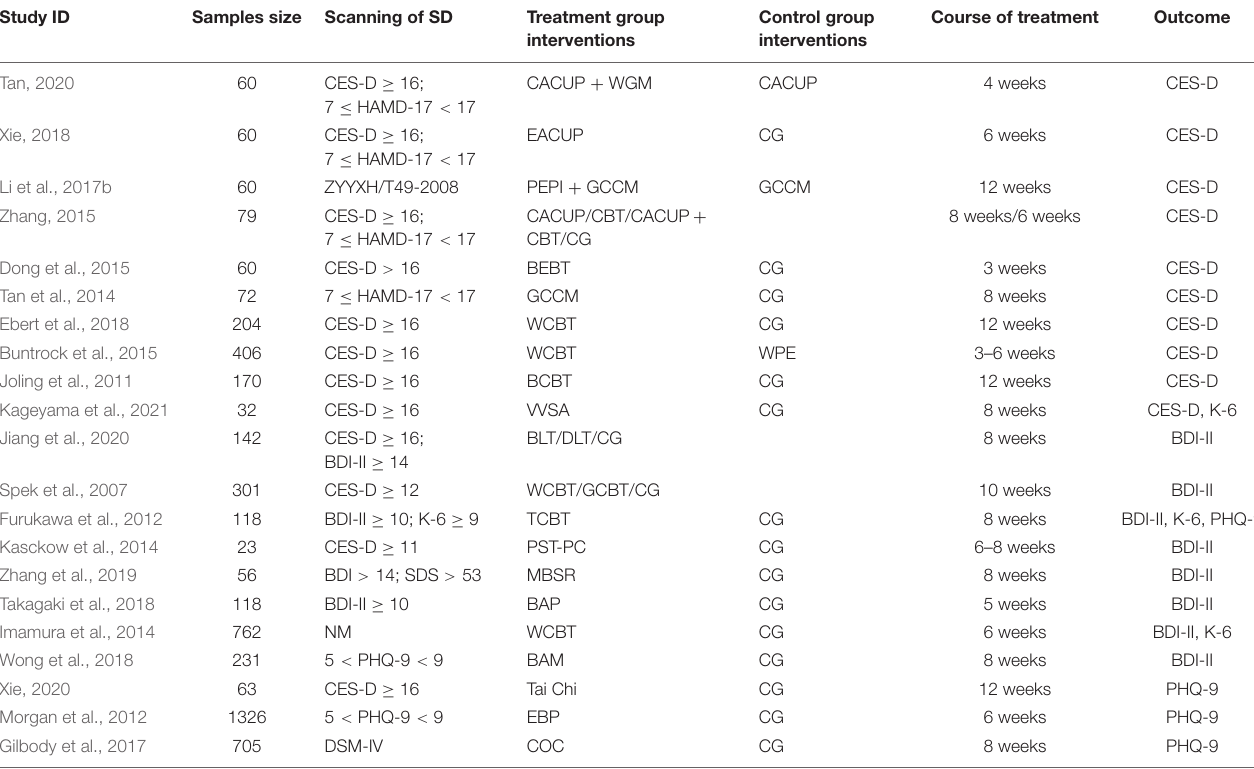
TABLE 1 Characteristic of included